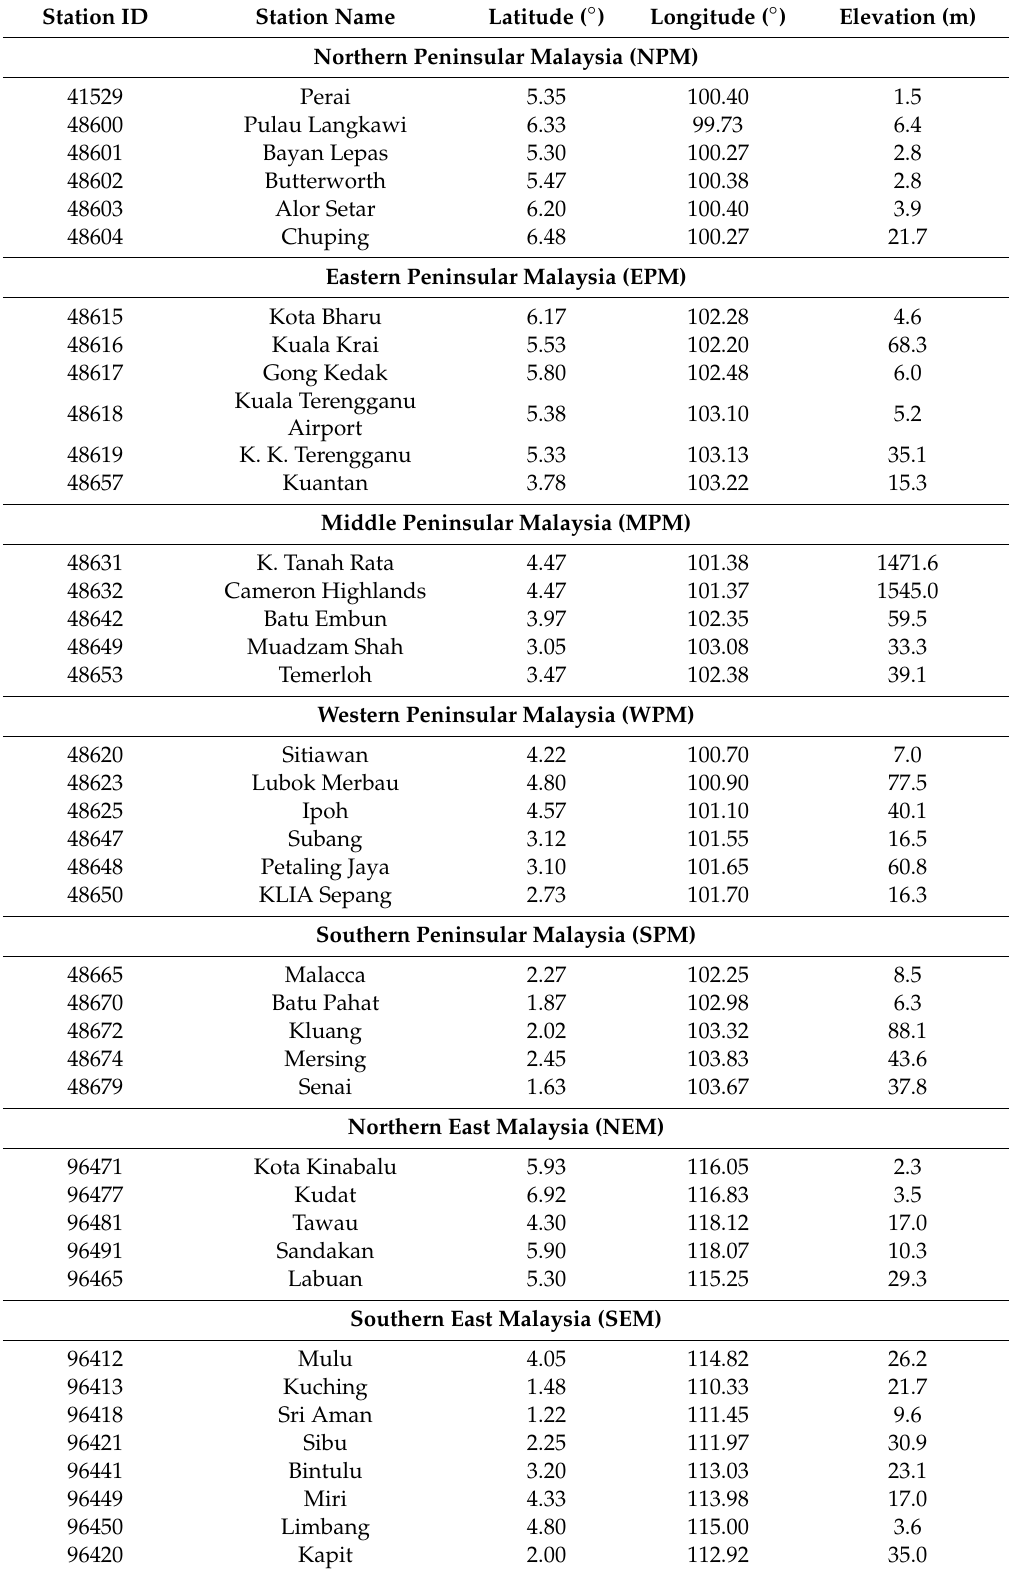
Table A1. Location and elevation of 41 rain gauge stations across